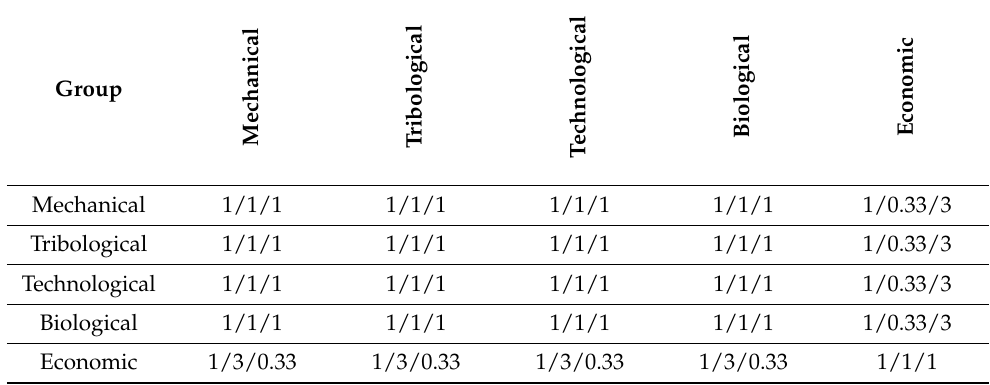
Table 14. The paired comparison of the groups. Preference #1/Preference #2/Preference #3.